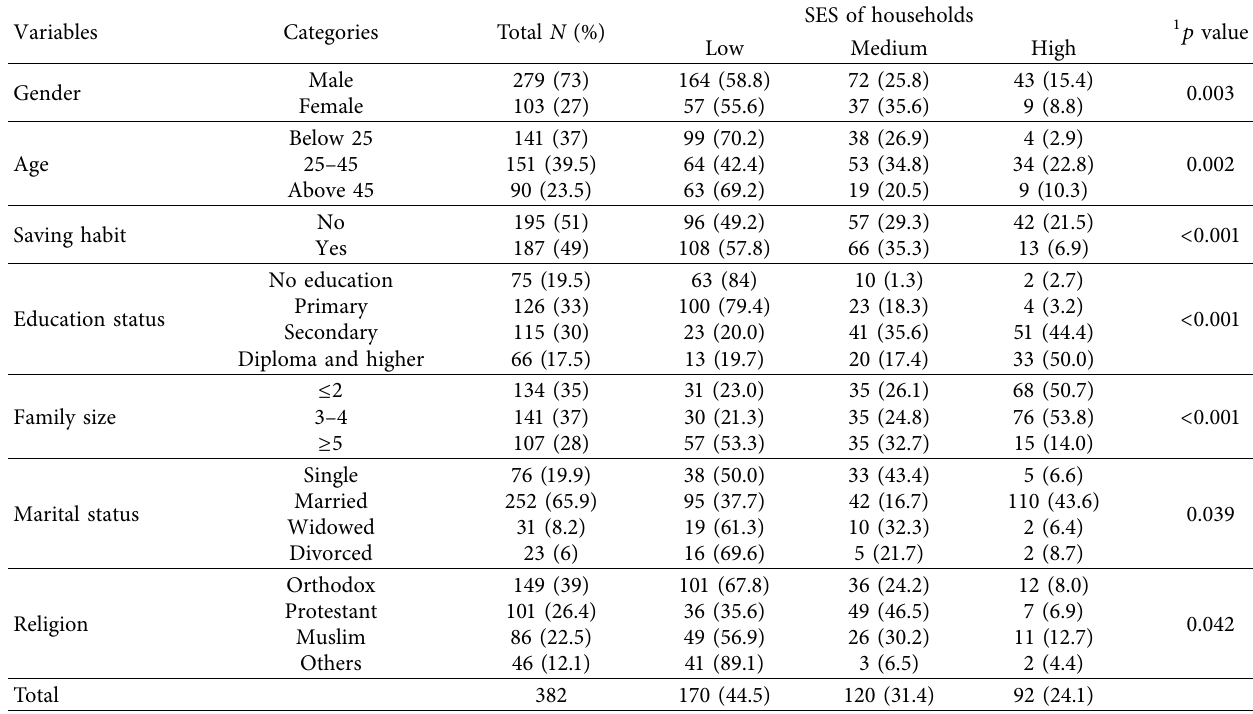
Table 1: Frequency distribution table of the respondents’ profile.